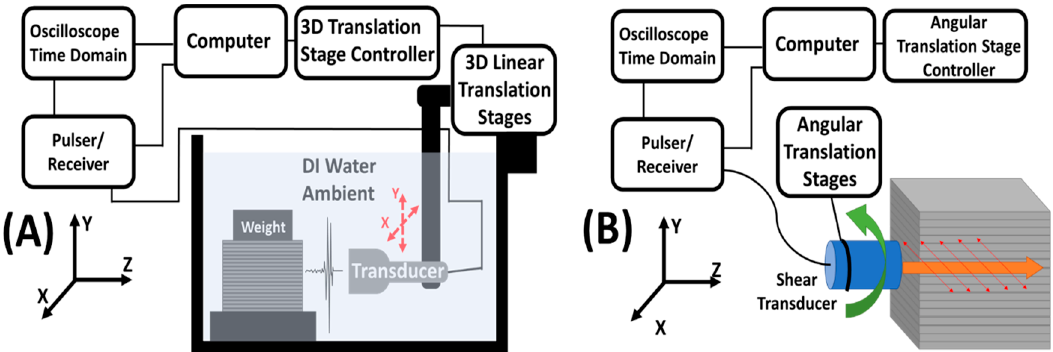
Figure 3. ( A ) Experimental setup of the immersion elastographic (EBME) raster scan. ( B ) Experimental setup of the angle-dependent shear wave velocity test. The angle indicated the slant between the infilled planes (along the X-axis) on the samples and the plane shear wave propagating. The shear (transverse) wave propagating along the Z-direction and oscillating in the XY plane. 0 ◦ indicated the shear wave oscillated along the X-axis and 90 ◦ referred the shear wave oscillated along the